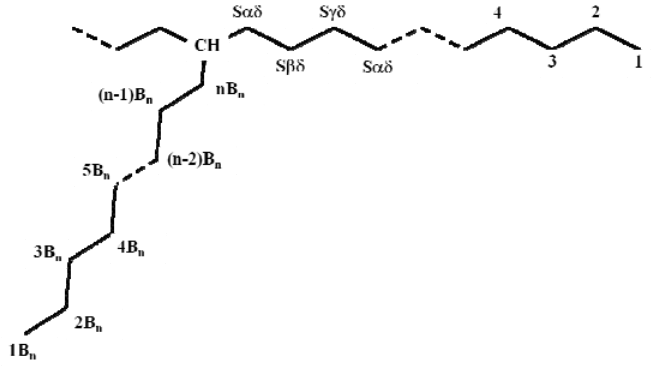
Figure 4. Resonance of the main chain methylenes and the side chain of the ethylene/1- olefin